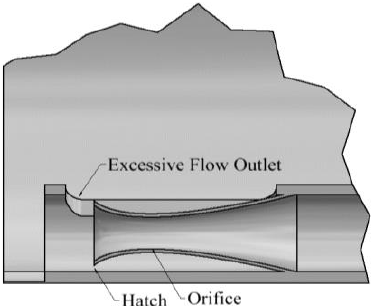
Figure 6. Detailed view of Figure 5a; (Hatch and Orifice, cross section).